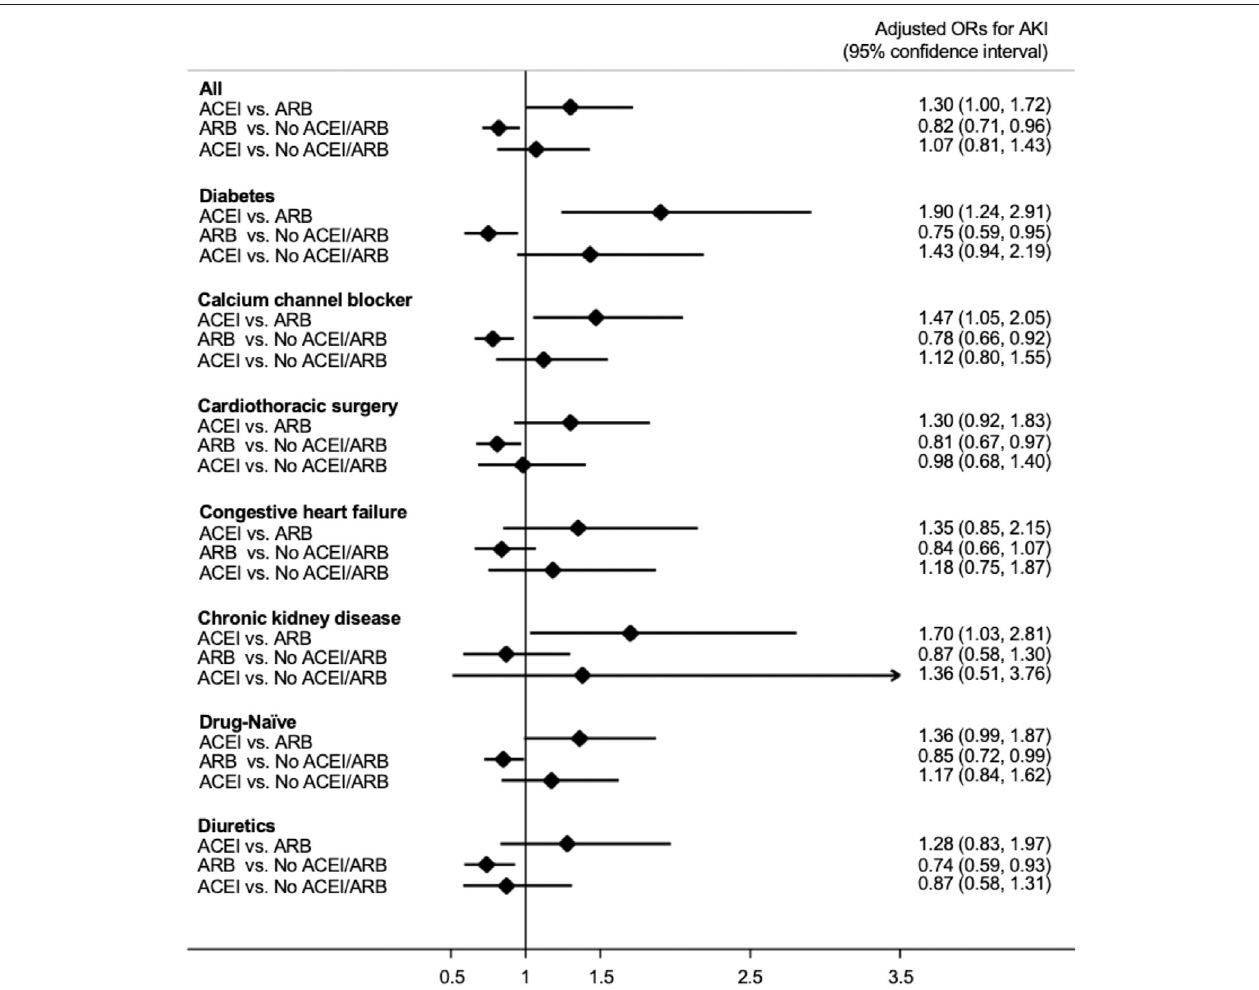
FIGURE 2 | Forest plot demonstrating the adjusted odd ratios for postoperative acute kidney injury in different subgroups with comparison between various conditionsofACEIorARBusage.Abbreviations:ACEI:angiotensin-converting-enzymeinhibitor;ARB:angiotensinreceptorblocker;NoACEI/ARB:NoACEIorARBuse within 90 days before surgery; Drug-Naïve: No ACEI or ARB use prior to 90 days before surgery.